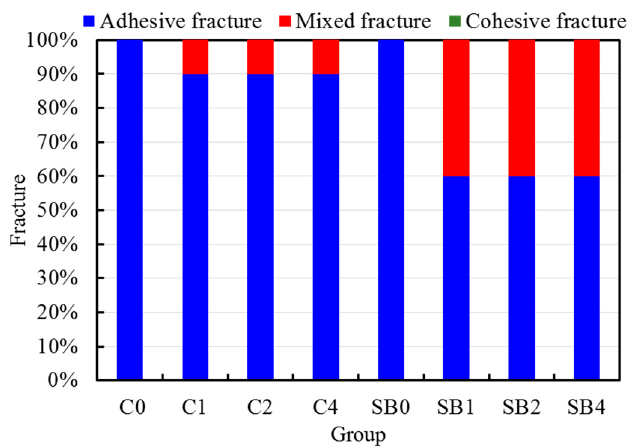
Figure 9. Fracture modes expressed as percentages of various zirconia–resin bonds after shear bond testing.